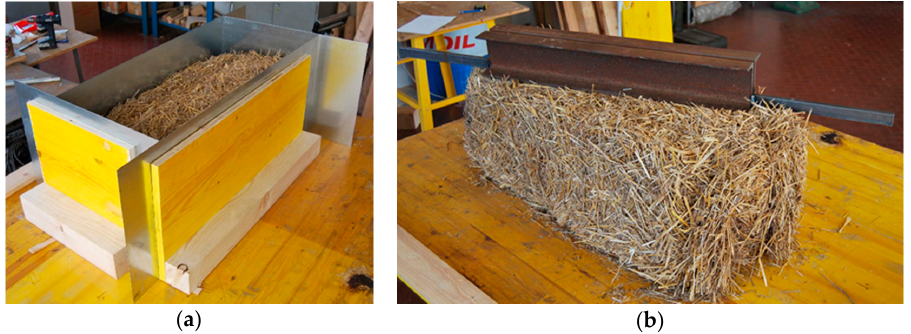
Figure 5. ( a ) The four pinwheel walls for measuring the RSB plant dimensions; ( b ) The straight edge for the measurement of the straw ‐ bale four vertical edge heights.